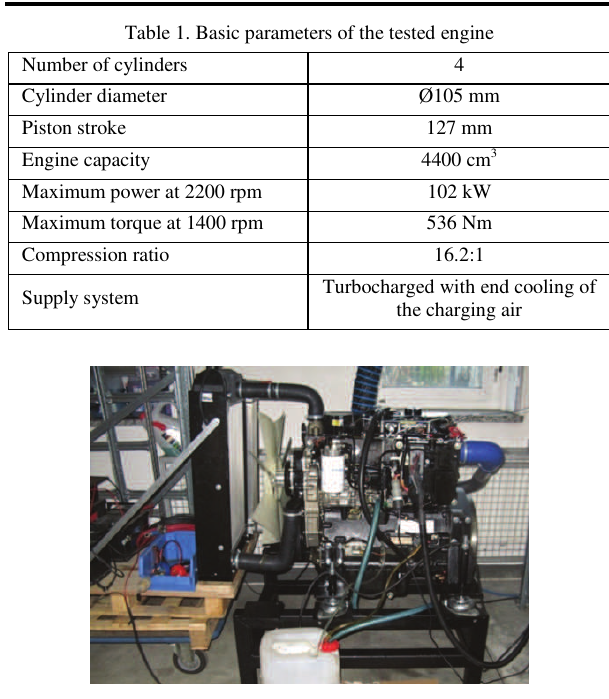
Fig. 2. A view of the PERKINS engine used for experimental research